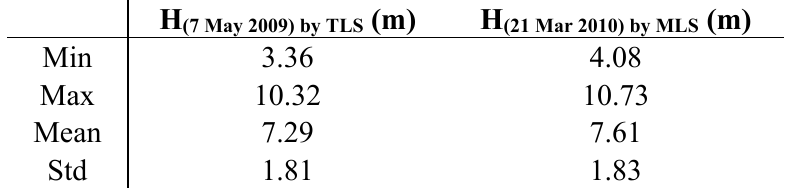
Table 1. Descriptive statistics of the 58 sample trees for test in terms of tree